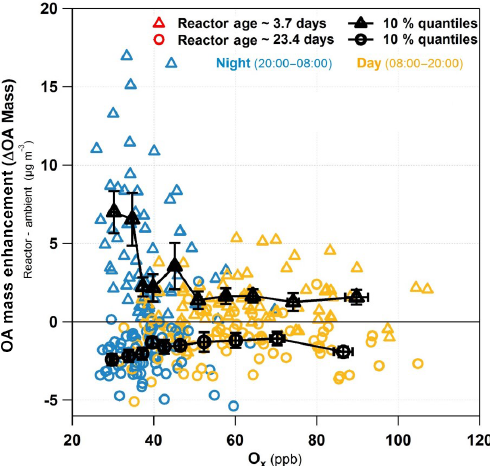
Figure 5. Reactor OA mass enhancement vs. ambient O x (odd oxygen; O 3 + NO 2 ) for all data in ∼ 3.7- and ∼ 23.5-day reac- tor age ranges during the sample period, color-coded by nighttime and daytime. Average for 10% quantiles are shown for ∼ 3.7 and ∼ 23.5 days of photochemical age, with error bars indicating stan- dard errors. Note that ambient O x is not itself playing a role in re- actor aging but rather is a proxy for ambient